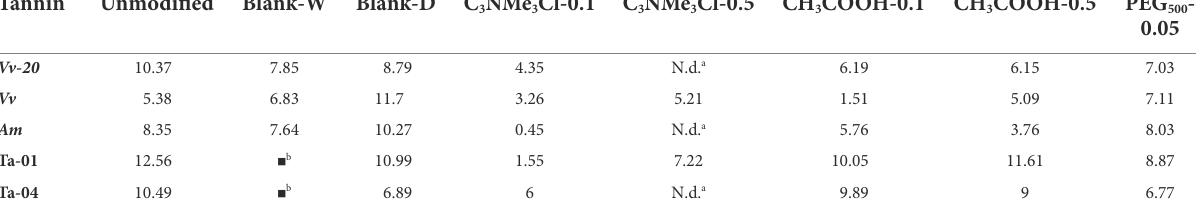
TABLE 1 Phenolic OH content (in mmol phenolic OH/g materials) of unmodified and derivatized tannins. Tannin Unmodified